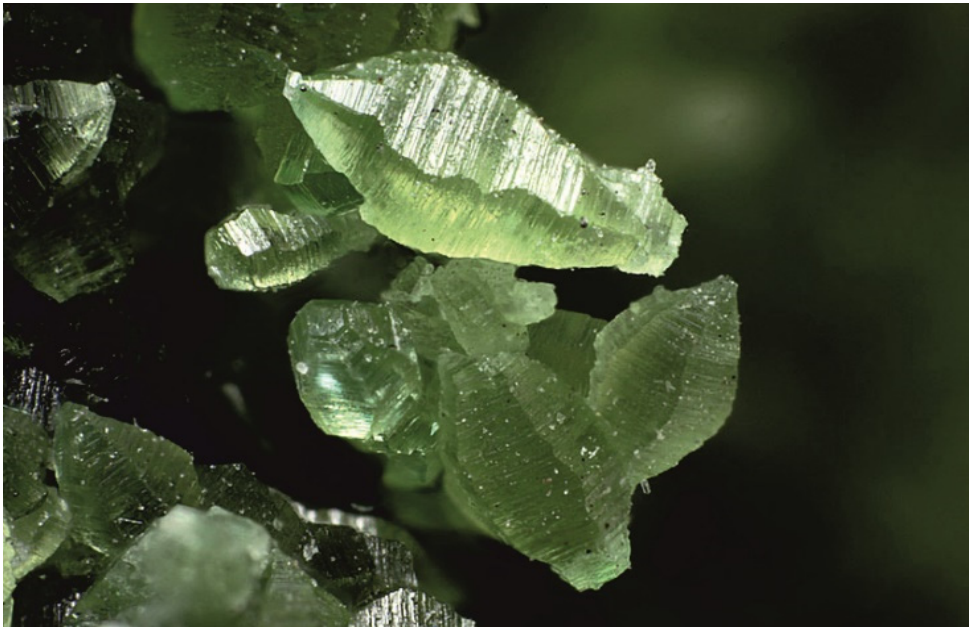
Figure 14. A 1.32 mm assemblage of green lizardite crystals from Sissone valley. (Collection of Domenico Preite, photo by Matteo Chinellato). Table 6. Raman analyses on the mineral phases occurring in the diopside ‐ bearing marbles;the band numbers and their assignments are reported: (Table a) right and (Table b) left side of the Sissonevalley. At about 1089 cm − 1 the typical absorption band of calcite is present. a